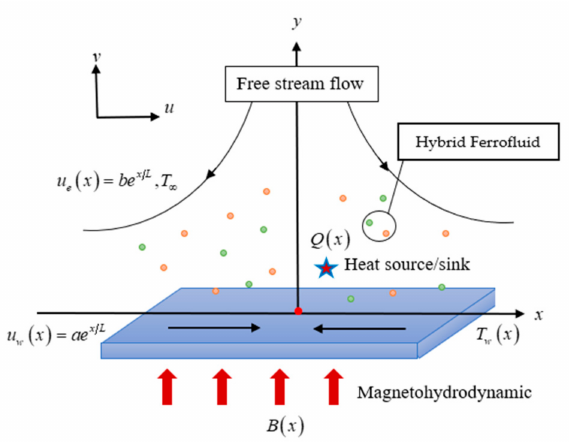
Figure 1. Flow model of shrinking sheet and its coordinate